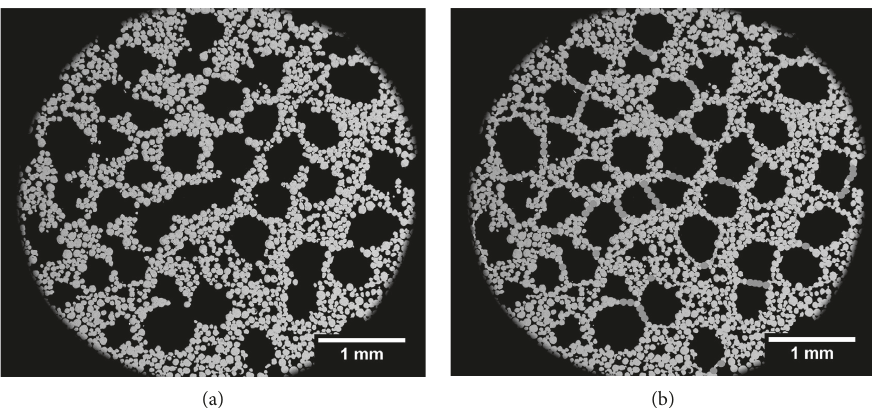
Figure 3: SEM image of a Ti foam: (a) before processing; (b) after defining the boundaries of the pores with spherical particles with size equal to the average particle size of the Ti particles.